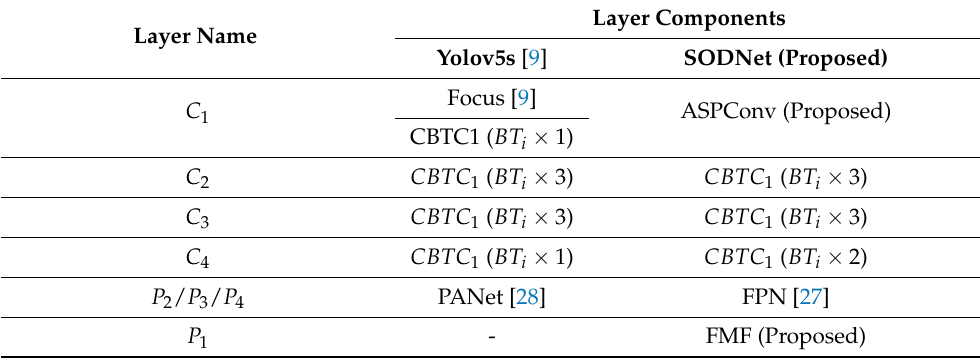
Figure 4. The structure of the proposed backbone module. Table 1. Structure comparison between Yolov5s [9] and the proposed SODNet. C i and P j are consistent with the definitions in Figure 2. CBTC 1 and CSBTC are consistent with the definitions in Figure 4. Layer